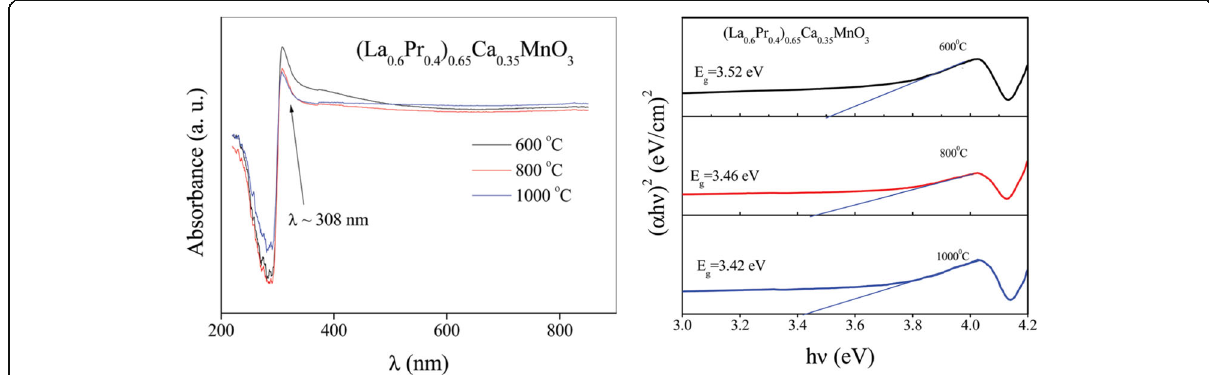
Fig. 28 a Ultraviolet-visible spectra of the (La 0.6 Pr 0.4 ) 0.65 Ca 0.35 MnO 3 nanoparticles sintered at 600 °C, 800 °C, and 1000 °C. b Variation of ( α h ν ) 2 versus photon energy h ν plot for the